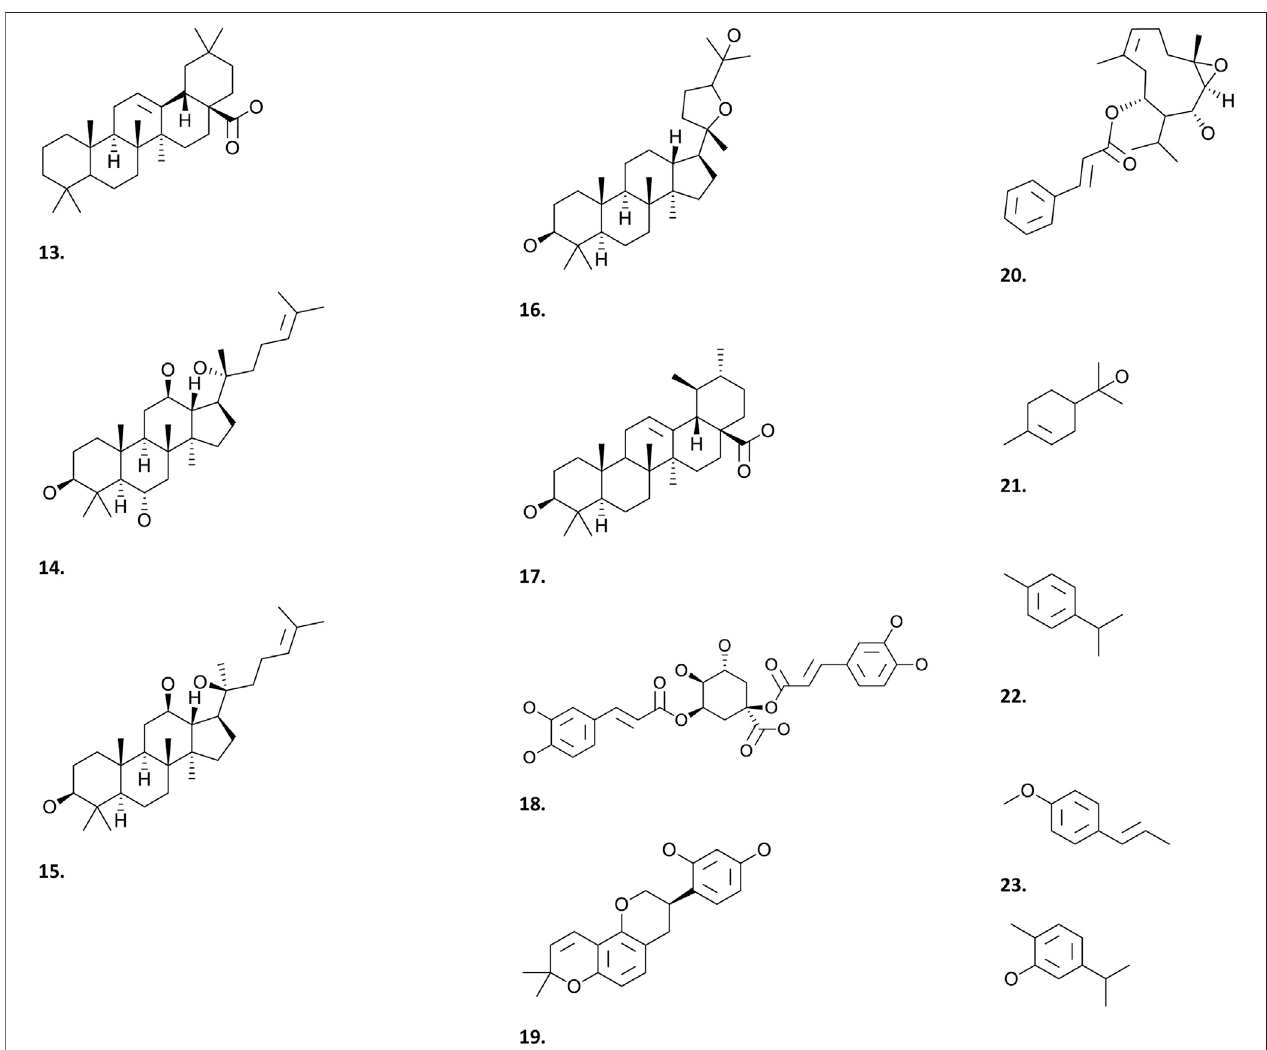
FIGURE 7 | Structures of some plant-derived secondary metabolites with antiviral activities.